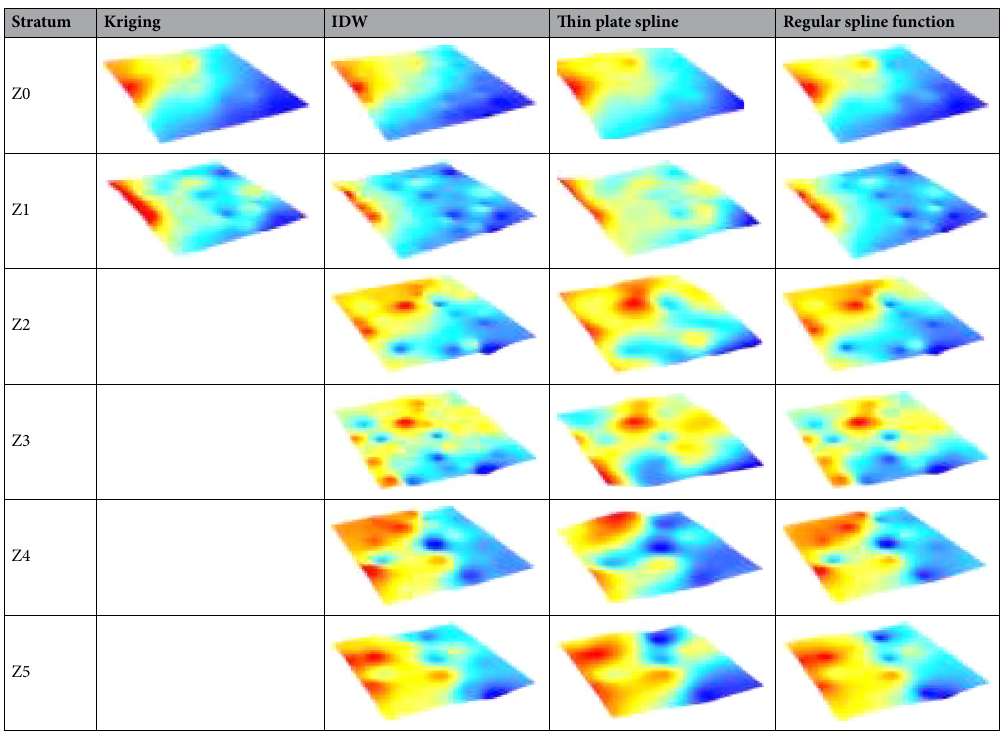
Table 1. Interpolation results of each stratum.